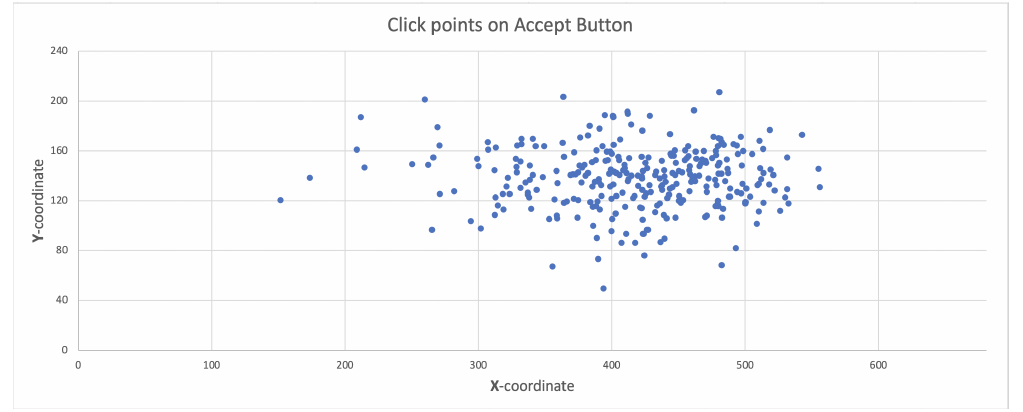
Figure 10. Click point positions on accept button.